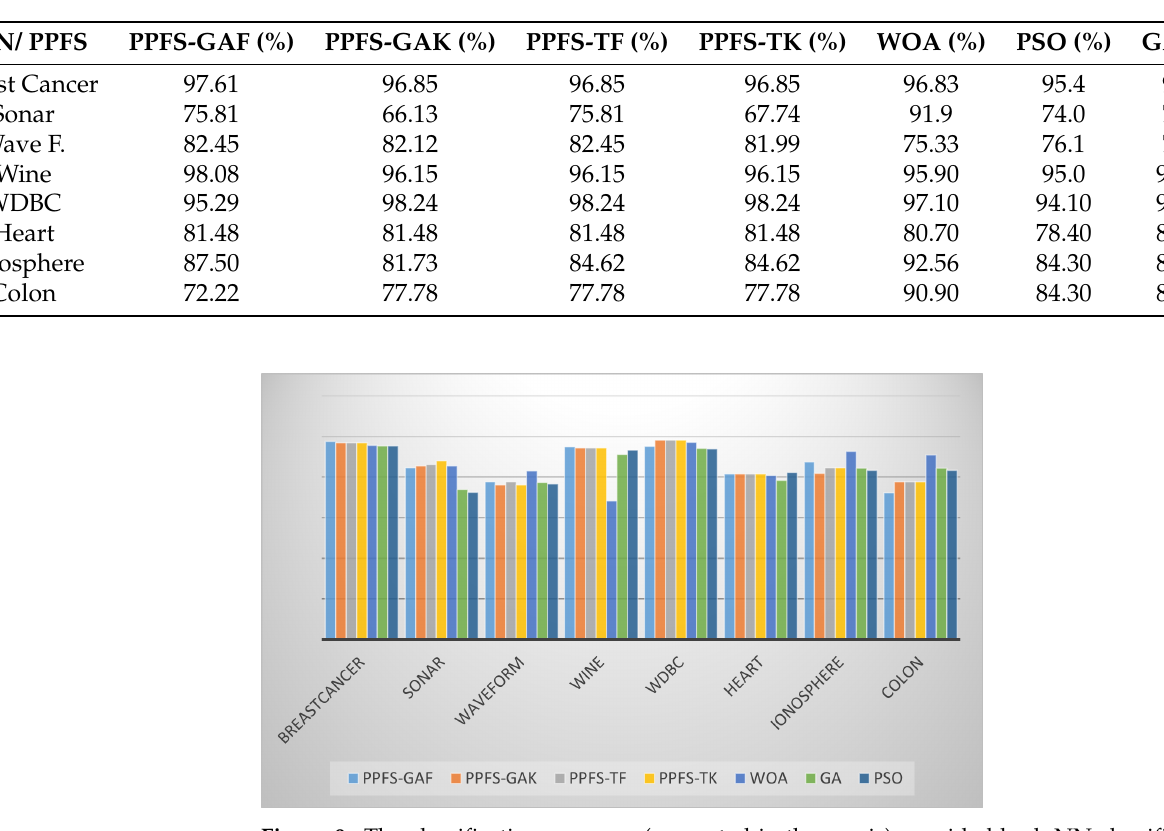
Figure 9. The classification accuracy (presented in the y axis) provided by k-NN classifier after applying the four PPFS, WOA, PSO, and GA feature selection. Table 10. The statistical results of GAF, WOA, PSO, and GA using 4 datasets.